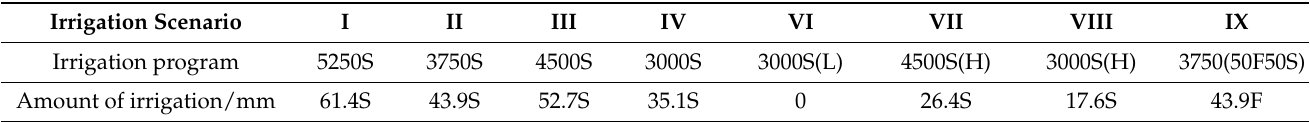
Table 1. The fourth irrigation quota of different irrigation scenarios.